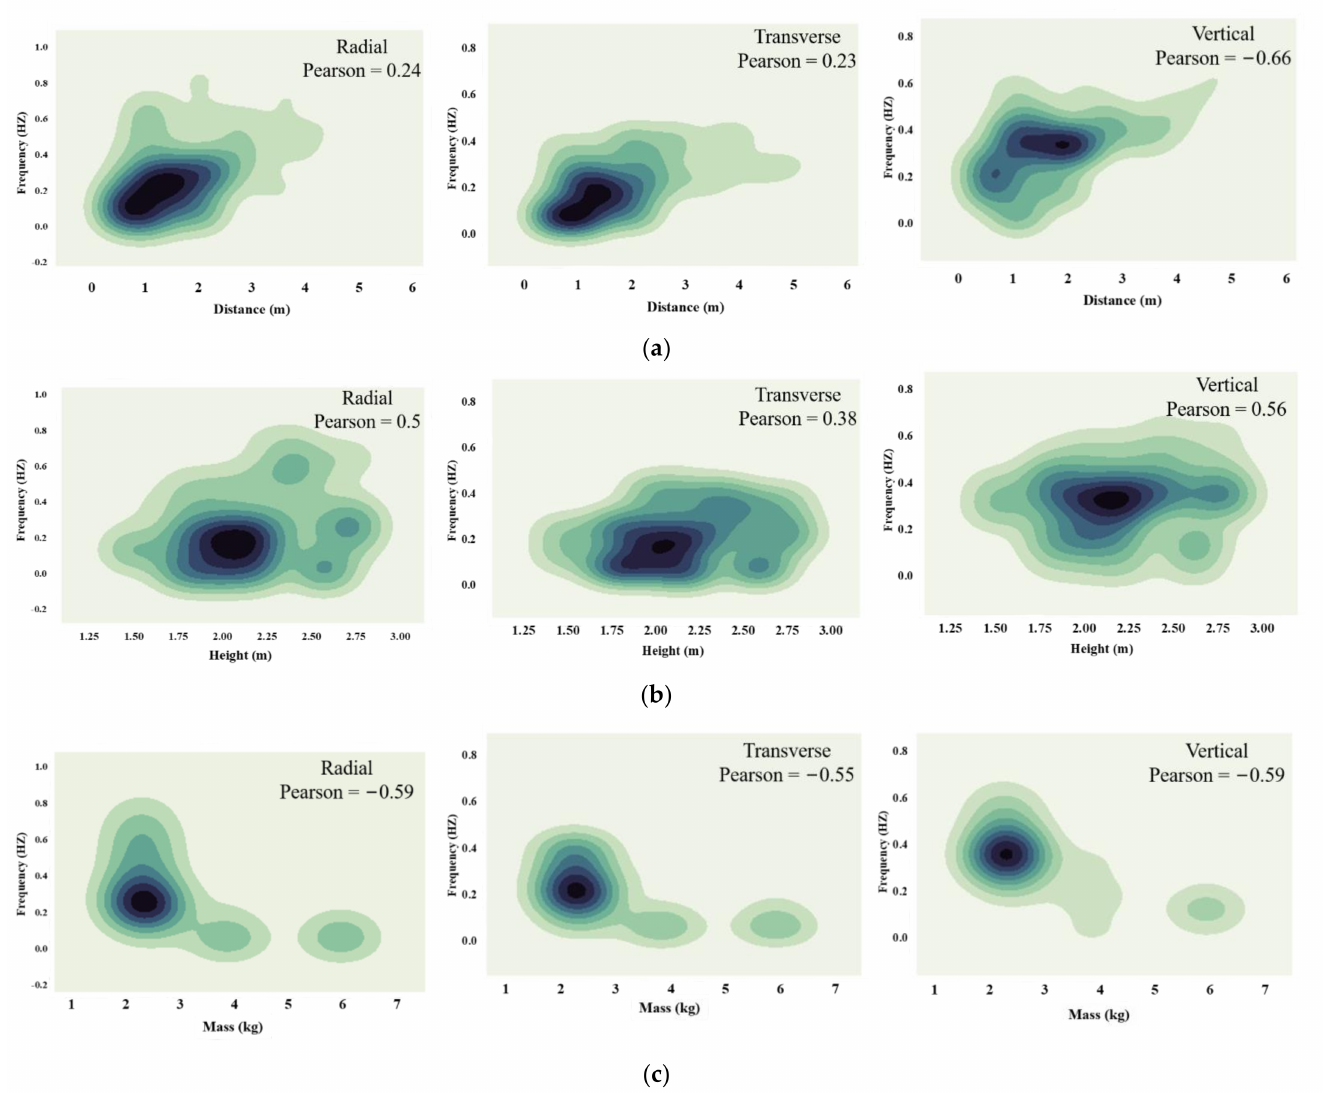
Figure 6. The KDE and Pearson correlation coefficient between the main parameters and frequency: ( a ) Distance; ( b ) Height; ( c )